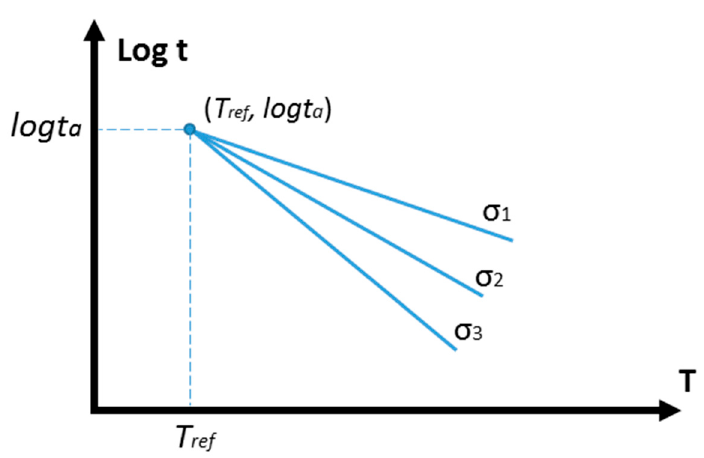
Figure 1. Plotting of T vs. log𝑡 .